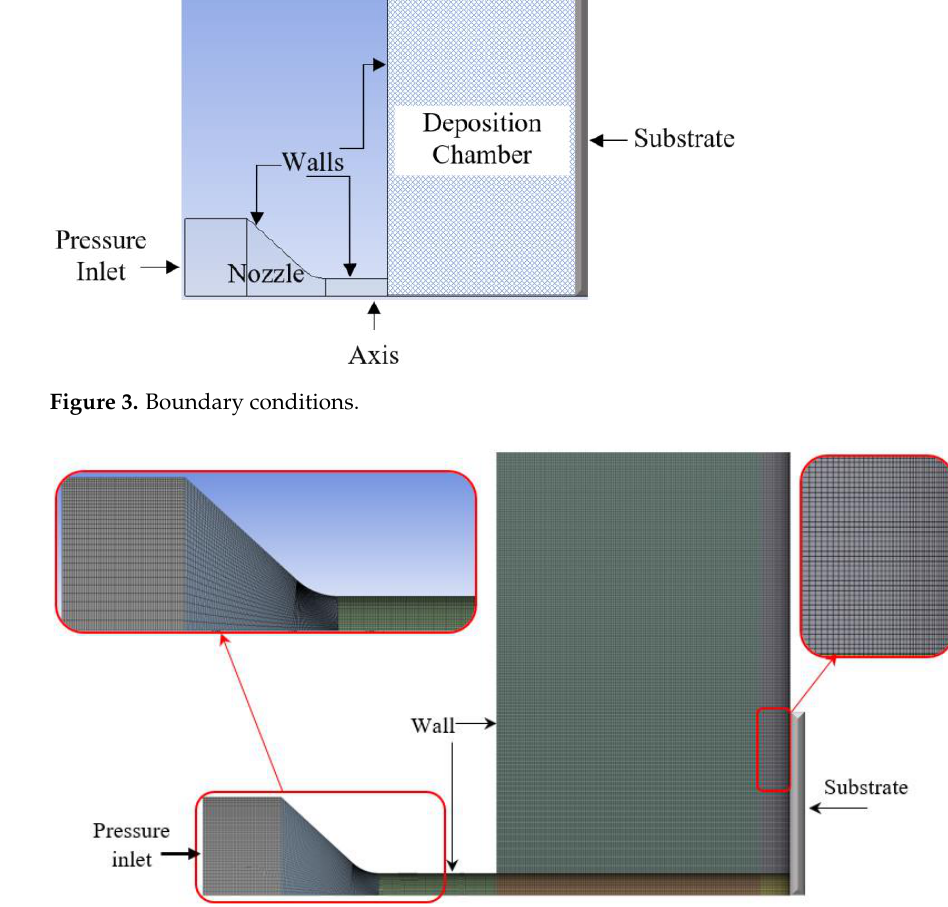
Figure 4. Computational domain and mesh for the numerical simulation. Figure 3. Boundary conditions.